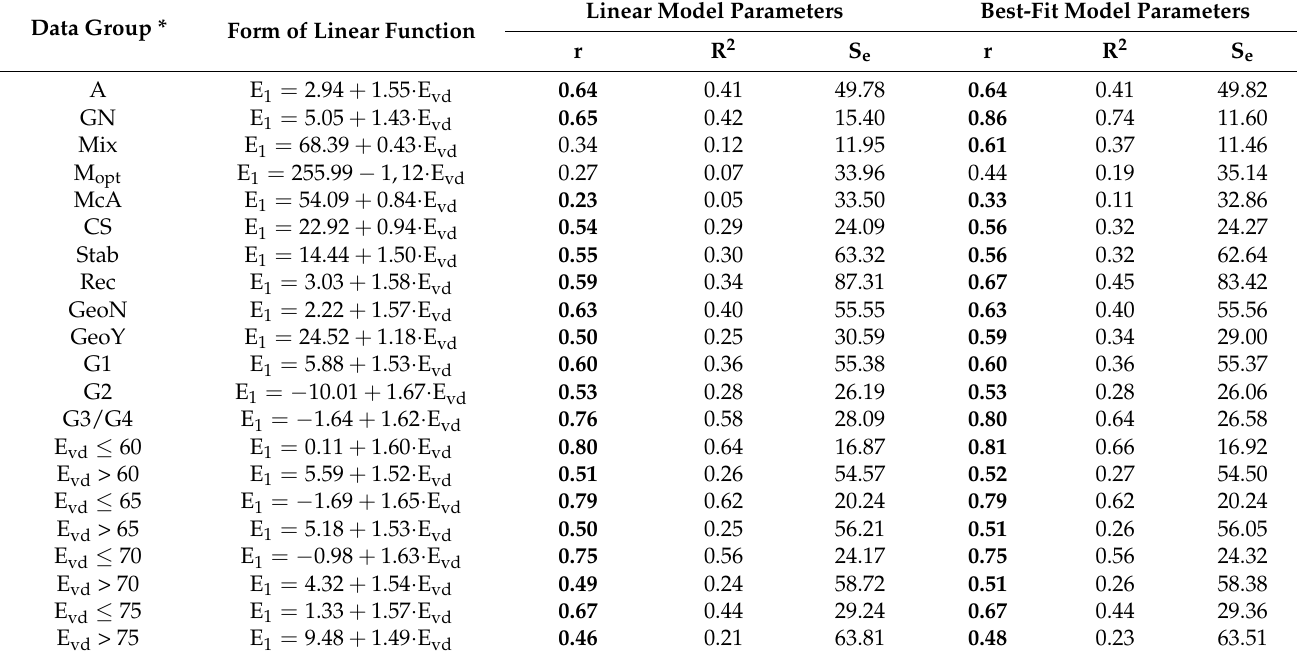
Table 3. Dependencies of dynamic deformation modulus E vd (LFWD Zorn, type ZFG 3000 GPS, 300 mm diameter load plate, 10 kg drop weight) on primary deformation modulus E 1 , tested with static load plate—simple regression (E 1 = f(E vd )).